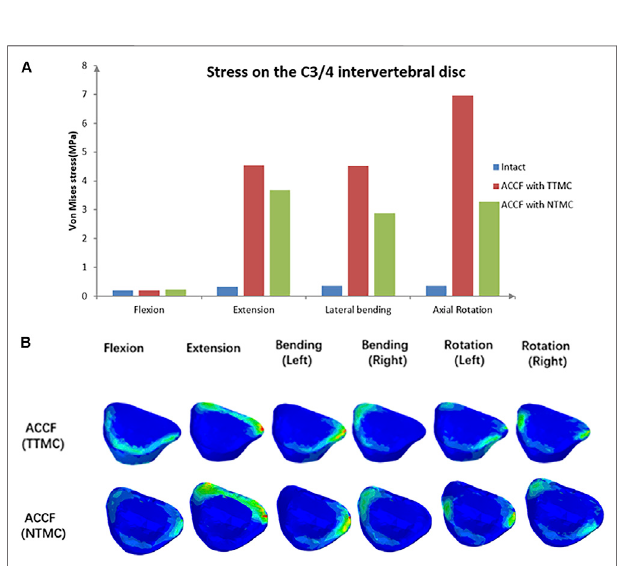
FIGURE 10 | (A) Comparisons of the maximum von Mises stresses in the IDP of the C3/4 segment among the intact model, TTMC model and NTMC model; (B) Stress cloud map of IDP of the C3/4 segment between TTMC and NTMC models.